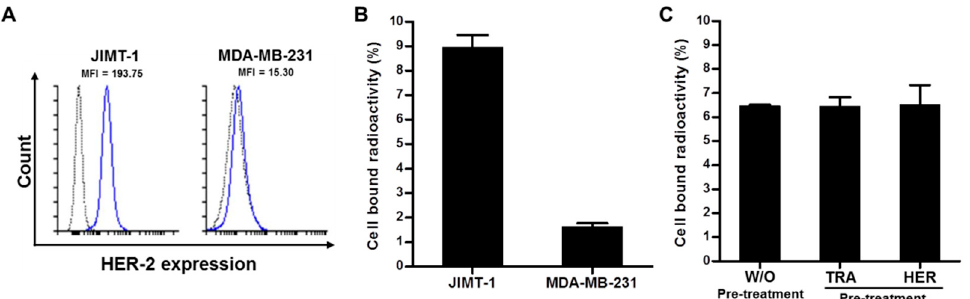
Figure 1. Analysis of HER2 expression level in breast cancer cells by flow cytometry and in vitro cell binding assay. ( A ) Flow cytometry in HER2-positive (JIMT-1) and negative (MDA-MB-231) breast cancer cells with pertuzumab. Gray-lined curve, isotype control; blue-lined curve, pertuzumab. ( B ) In vitro cell binding assay of 89 Zr-DFO-pertuzumab in breast cancer cells. ( C ) In vitro cell binding assay of 89 Zr-DFO-pertuzumab in JIMT-1 breast cancer cell by with or without (w/o) pre-treatment of trastuzumab (TRA) and herzuma (HER).